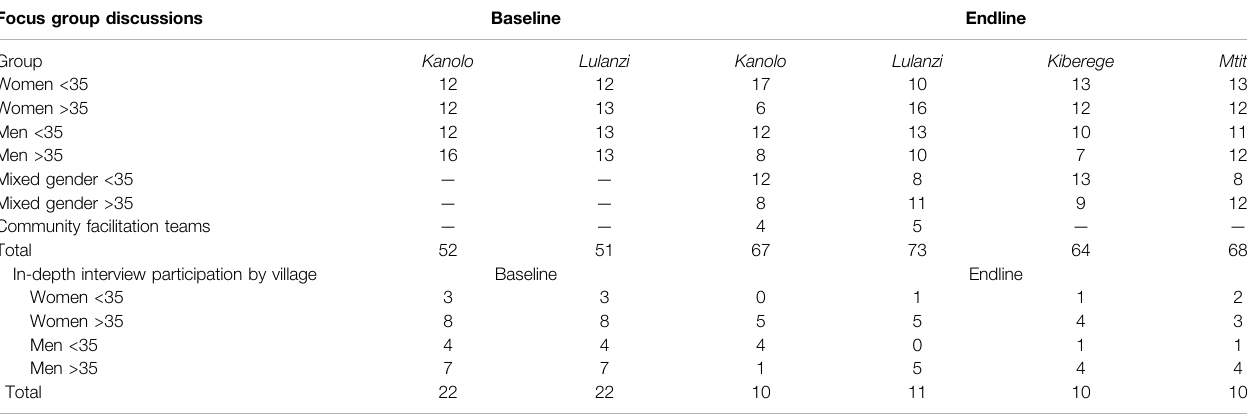
TABLE 1 | Participant numbers for the baseline and endline assessments Focus group